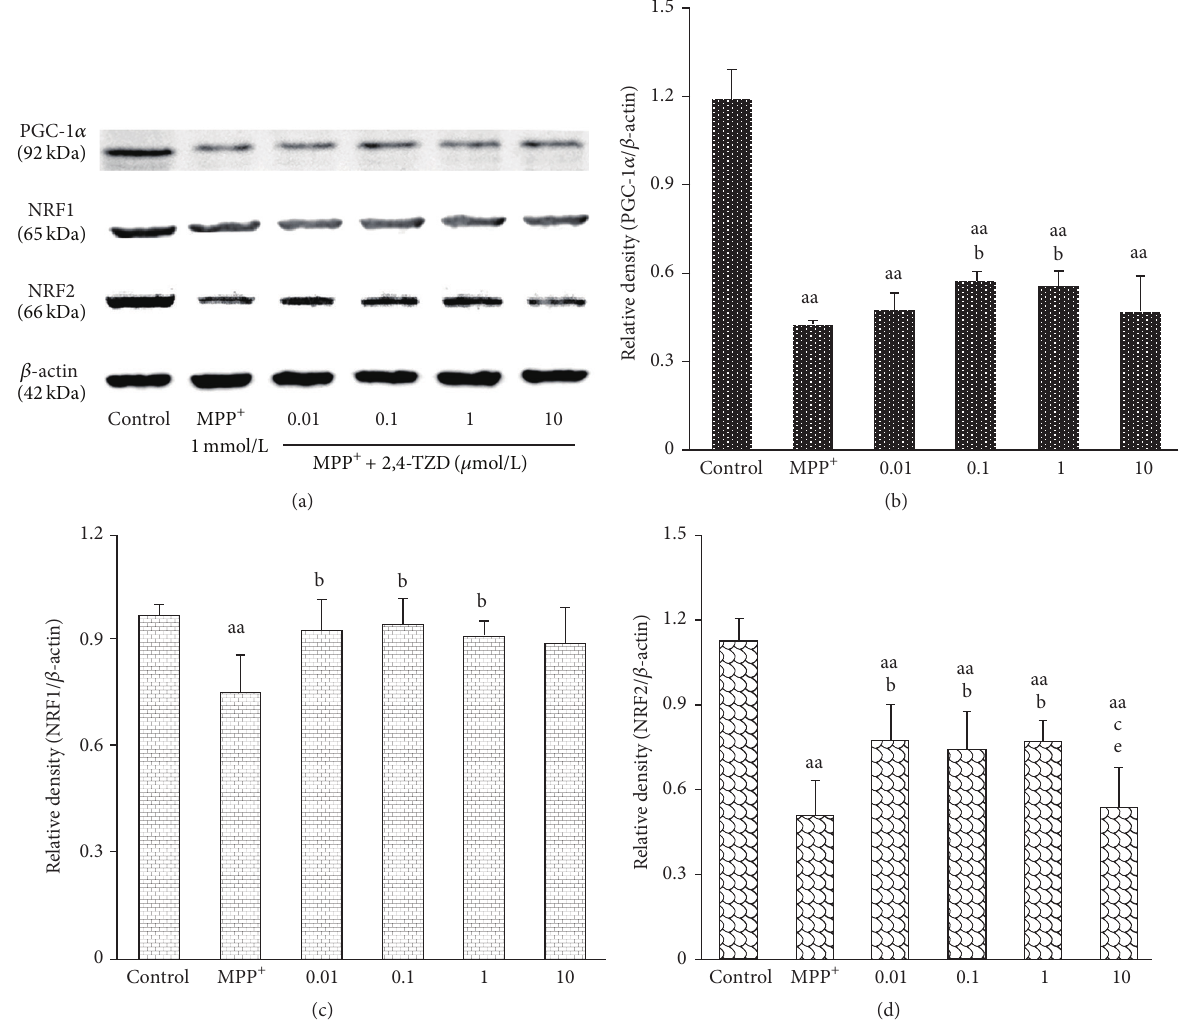
Figure 5: Effect of thiazolidinedione on PGC-1 𝛼 , NRF1, and NRF2 protein levels. (a) The expression of PGC-1 𝛼 , NRF1, and NRF2 in different groups; 𝛽 -actin was used as the loading control. ((b)–(d)) PGC-1 𝛼 , NRF1, and NRF2 protein levels. “aa” indicates 𝑃 < 0.01 , compared with control group; “b” indicates 𝑃 < 0.05 , compared with MPP + group; “c” indicates 𝑃 < 0.05 , compared with 0.01 𝜇 mol/L 2,4-TZD group; “e” indicates 𝑃 < 0.05 , compared with 1 𝜇 mol/L 2,4-TZD